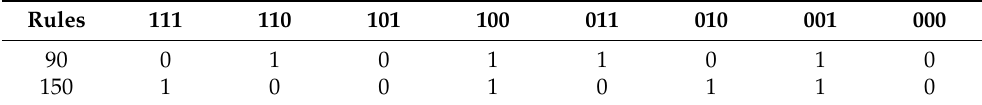
Table 1. Evolution rules that determine the LHCA future